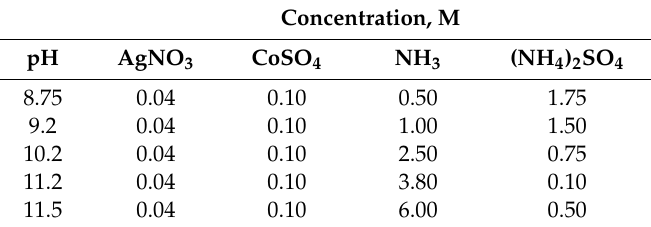
Table 1. Composition of electroless silver-plating solutions.